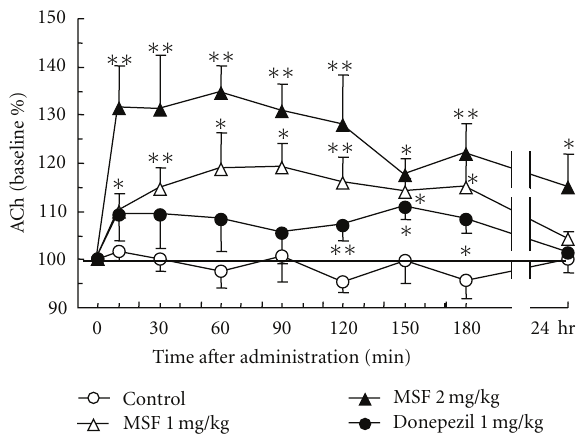
Figure 2: E ff ect of MSF and donepezil on the level of extracellular choline in the freely moving rats. Data are expressed as percentage changes from baseline. Each value represents the mean ± S.E.M. of five